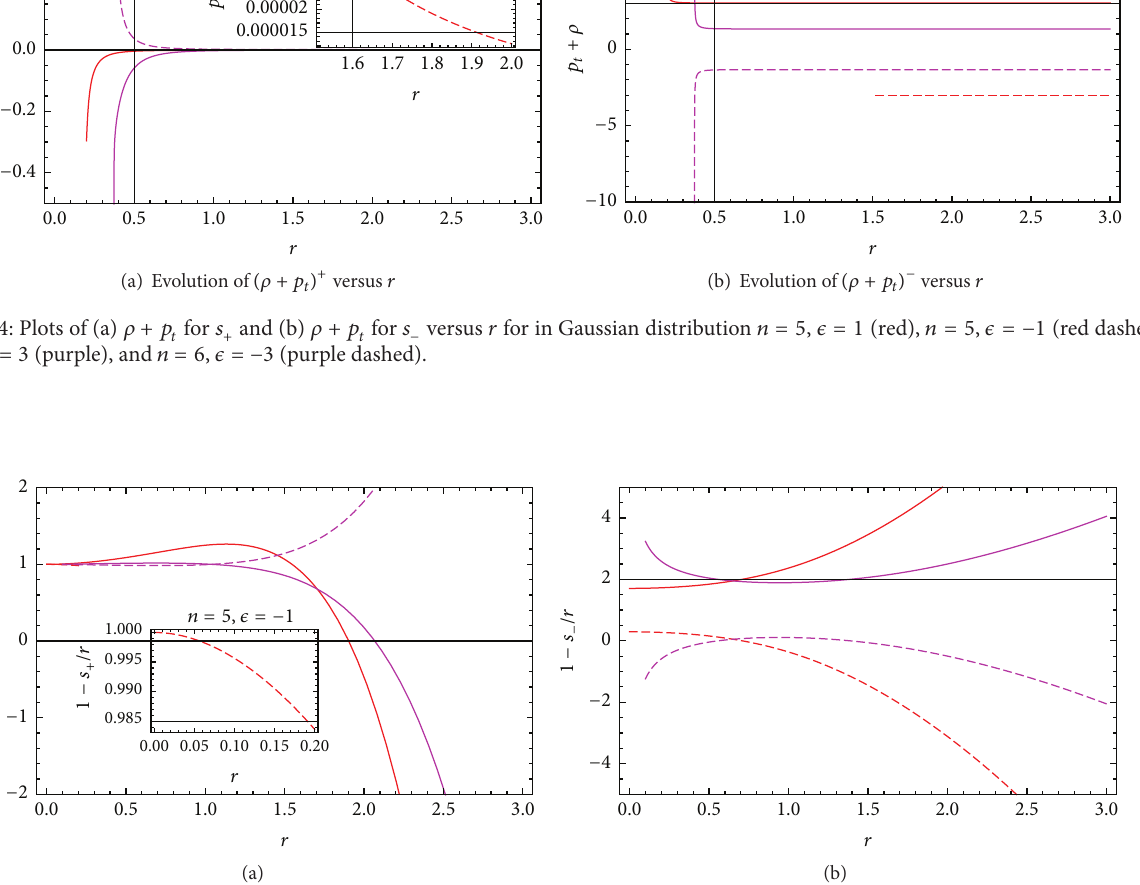
Figure 5: Plots of (a) 1−𝑠 + /𝑟 and (b) 1−𝑠 − /𝑟 versus 𝑟 in Lorentzian distribution for 𝑛 = 5 , 𝜖 = 1 (red), 𝑛 = 5 , 𝜖 = −1 (red dashed), and 𝑛 = 6 , 𝜖 = 3